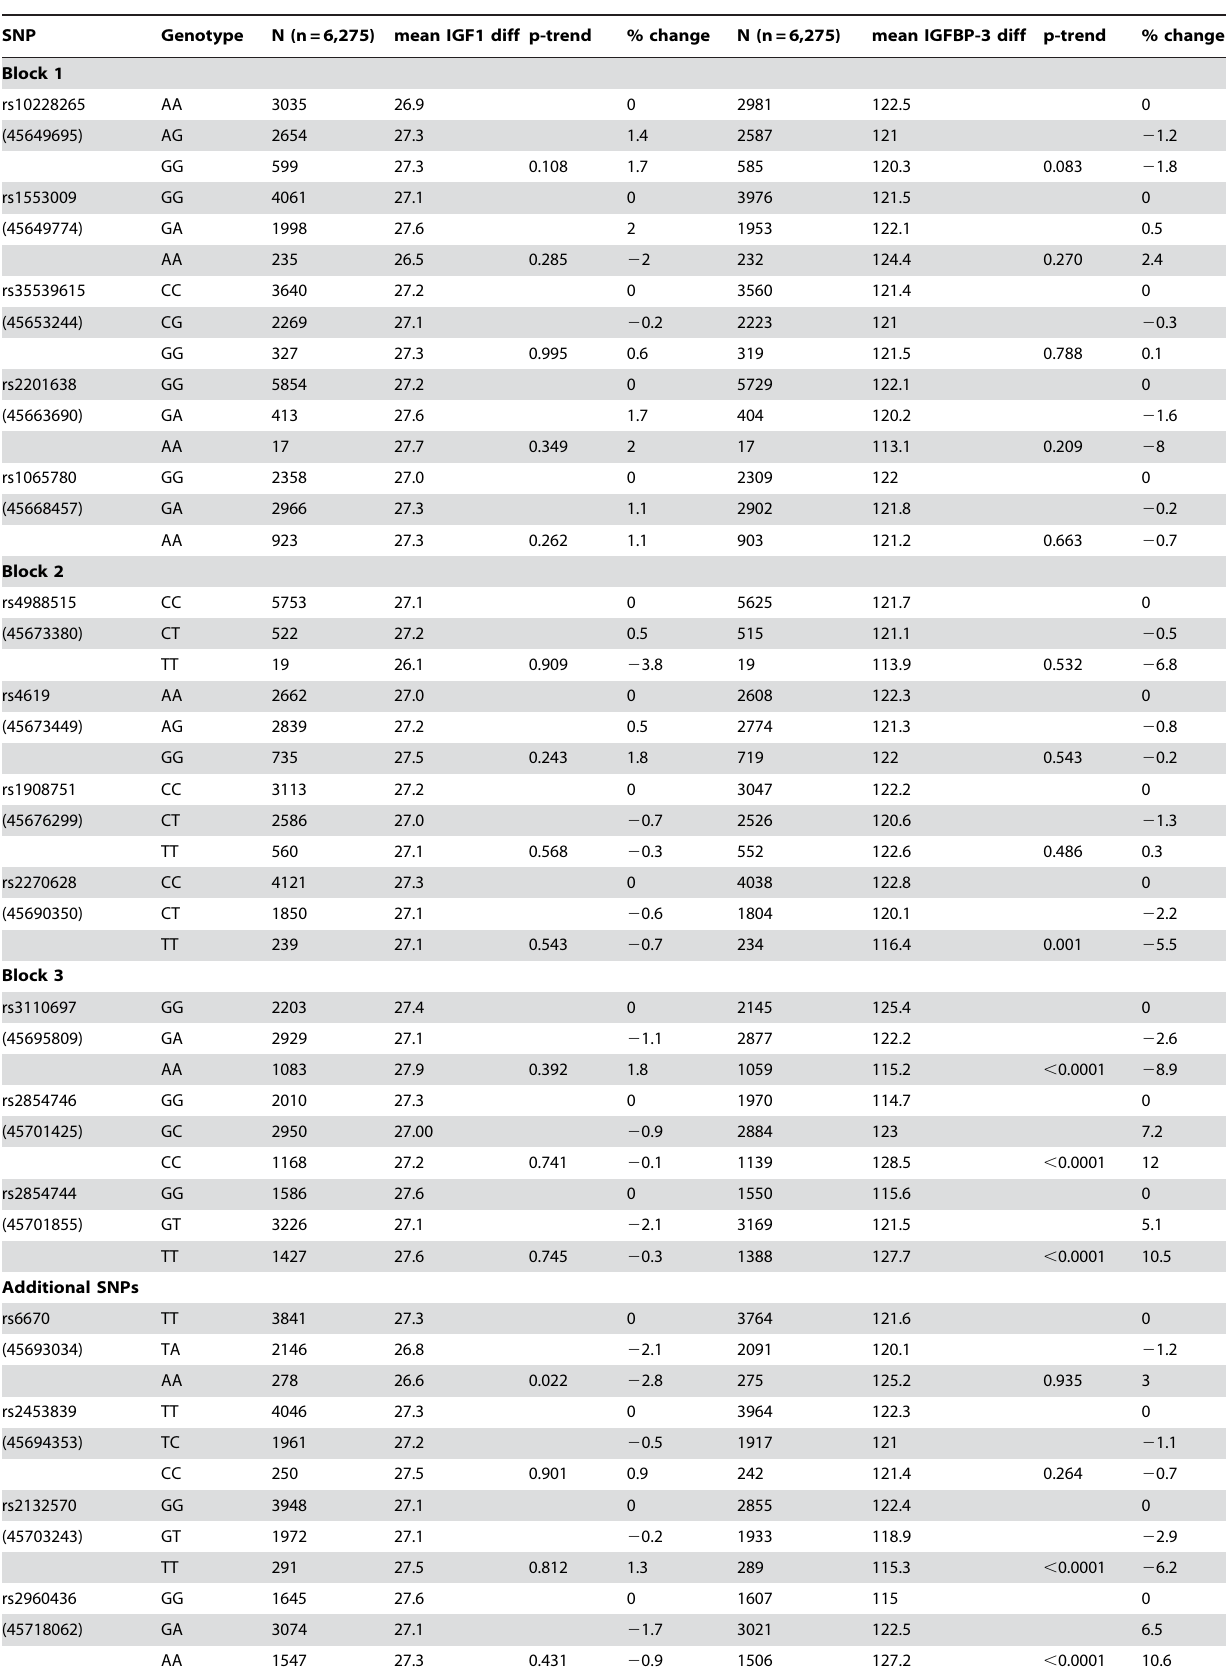
Table 2. Associations between IGFBP1 and IGFBP3 SNPs and mean circulating IGF-I and IGFBP-3 levels in the BPC3.